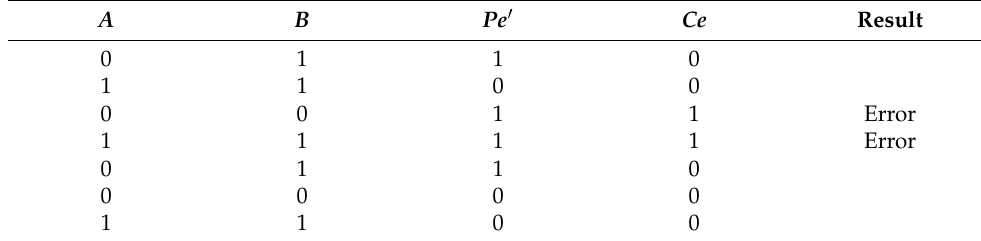
Table 2. Truth table of even parity checker.